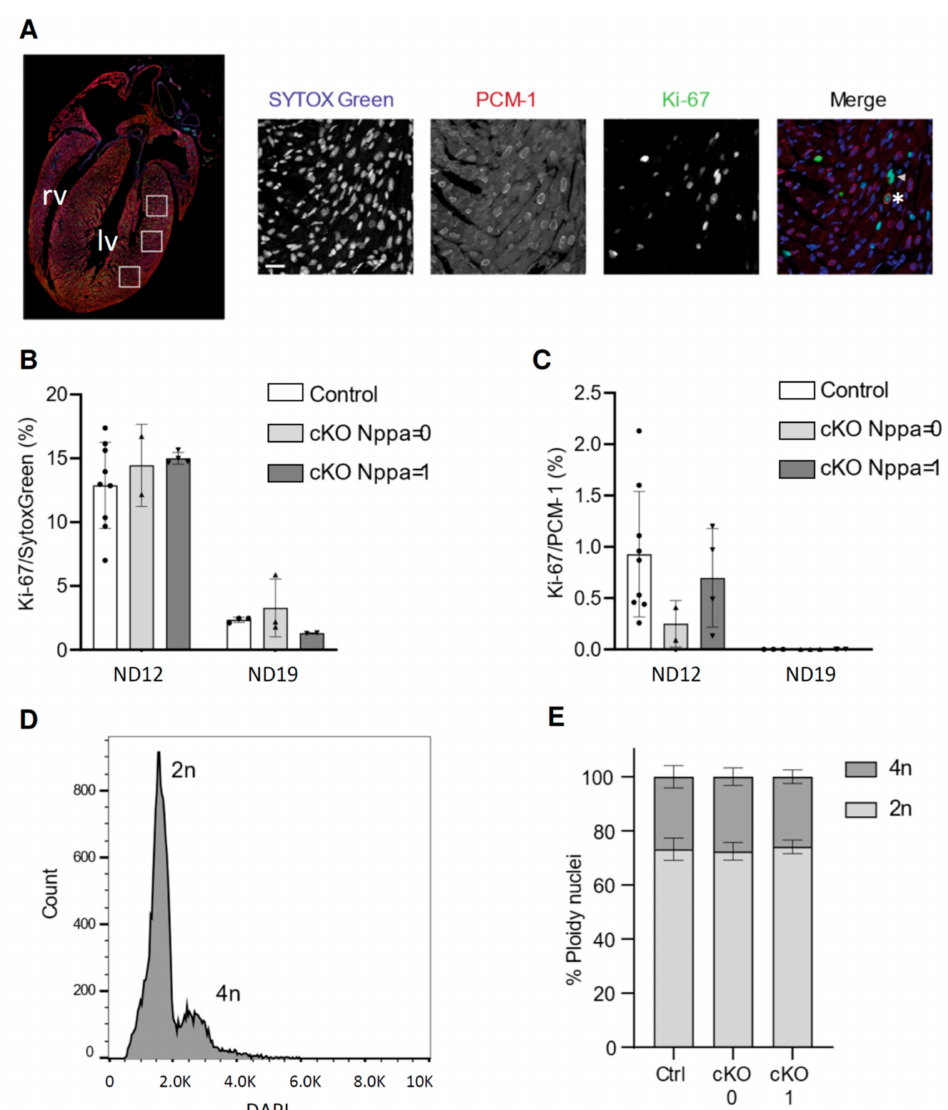
Figure 3. ( A ) Overview of regions within the left ventricle in which cell-cycle activity was determined. ( B ) Immunohistochemical staining of SYTOX Green as nuclear stain, pericentriolar material 1 (PCM- 1), and Ki-67 of a part of the left ventricle at postnatal day (P) 12. The arrowhead indicates an example of a Ki-67-positive nucleus. * indicates a Ki-67 and PCM-1 double-positive nucleus. Scale bar indicates 10 µ m. ( C ) Ratios of Ki-67-positive nuclei (PCM-1-negative) and Ki-67/PCM-1-positive nuclei in the left ventricles of P12 and P19 mice (P12: N Nppa = 9, N Nppa = 0 = 2, N Nppa = 1 = 4, P19: N control = 3, and N Nppa = 1 = 4). ( D ) DNA (DAPI intensity) histogram of cardiomyocyte nuclei. ( E ) Percentage of PCM-1-positive nuclei with a diploid (2n) and tetraploid (4n) DNA content of control and cKO mice based on the stress score according their heart-weight-to-body-weight ratios (HW/BW) (N control = 3, N cKO 0 = 3, and N cKO 1 = 3). Lv. Left ventricle; rv, right